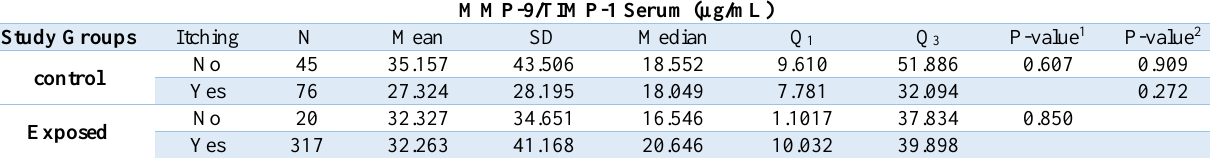
Table 2. MMP-9/TIMP-1 Complex in the Control and Sulfur Mustard Exposed Groups With Itching